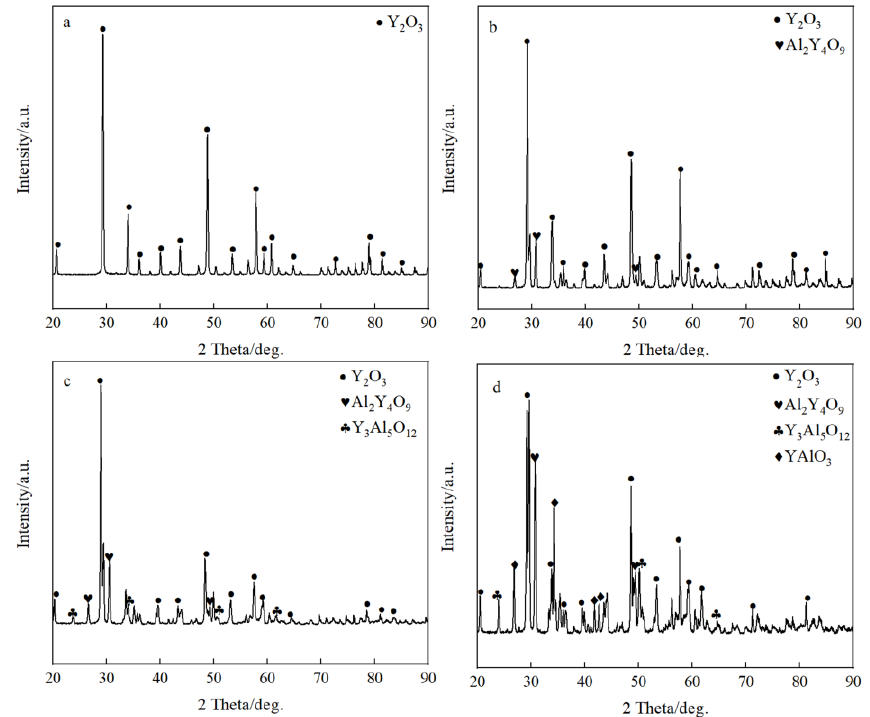
Figure 2. T he XRD spectrum of composite crucibles before the melting experiment. ( a ) The pure Y 2 O 3 crucible; ( b ) Al 2 O 3 -A crucible, containing 3.5 wt % Al 2 O 3 ; ( c ) Al 2 O 3 -B crucible, containing 7.0 wt % Al 2 O 3 ; ( d ) Al 2 O 3 -C crucible, containing 10.5 wt % Al 2 O 3